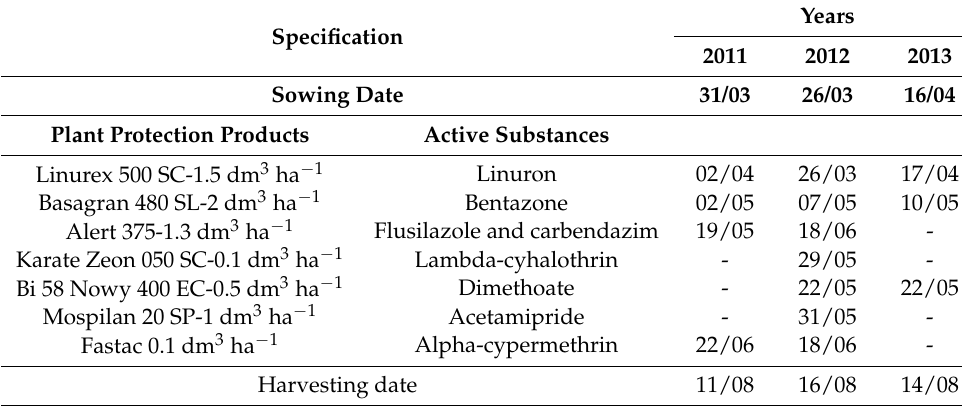
Table 3. Sowing and harvesting date and plant protection of faba bean in years 2011–2013.